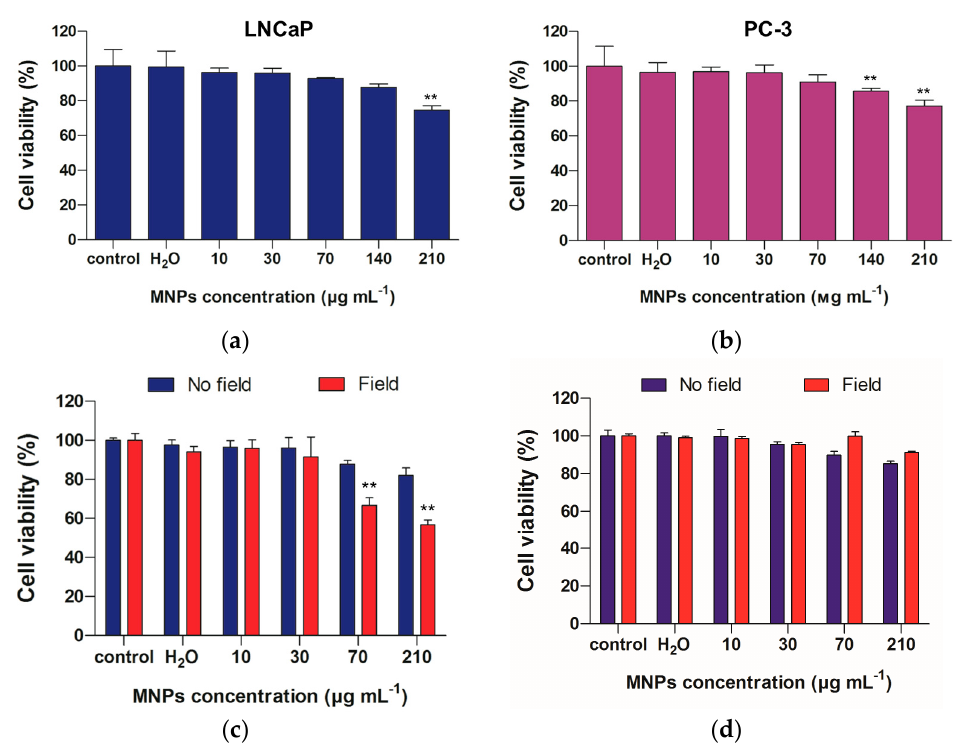
Figure 6. Magnetite–gold dumbbell nanoparticles’ effect on cell viability. ( a ) Histogram of LNCaP cell survival after 48 h incubation with MNPs-Cy5; ( b ) Histogram of PC-3 cell survival after 48 h incubation with MNPs; ( c ) Histogram of LNCaP cell survival after 3 h incubation with MNPs under pulsed magnetic field exposure (f = 31 Hz and B = 175 mT, 30 s pulse–30 s pause) and without it; ( d ) Histogram of PC-3 cell survival after 3 h incubation with MNPs under pulsed magnetic field expo- sure and without it. MTS assay. ** p < 0.05 ( t -test). In panels ( a , b ), the results were compared with control cells, and panels ( c , d ) with those without field application.